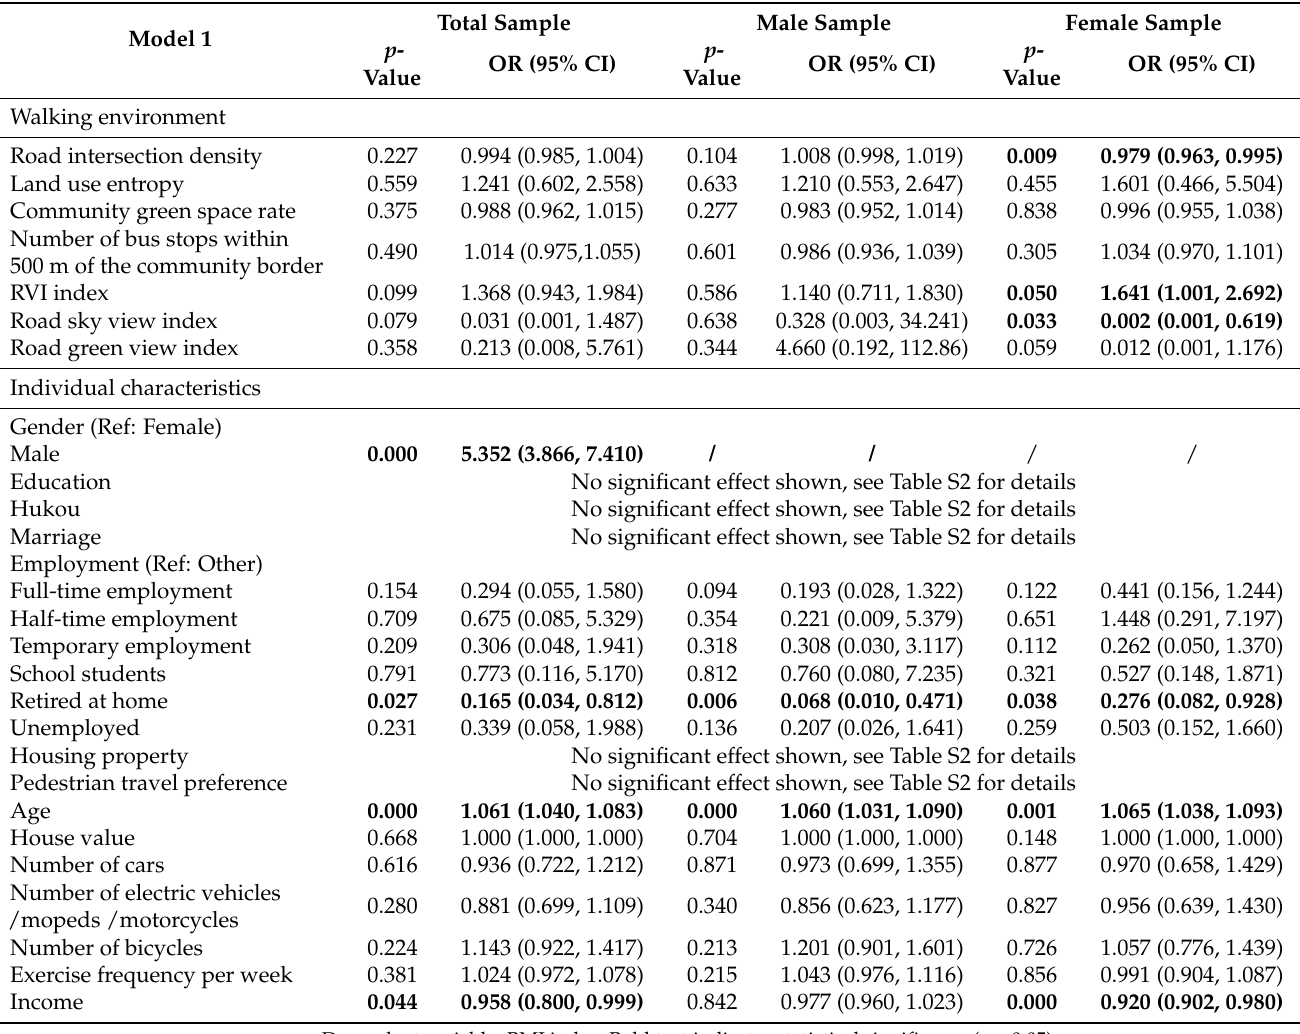
Table 2. Generalized linear estimation equations testing for the increased BMI among residents based on walking